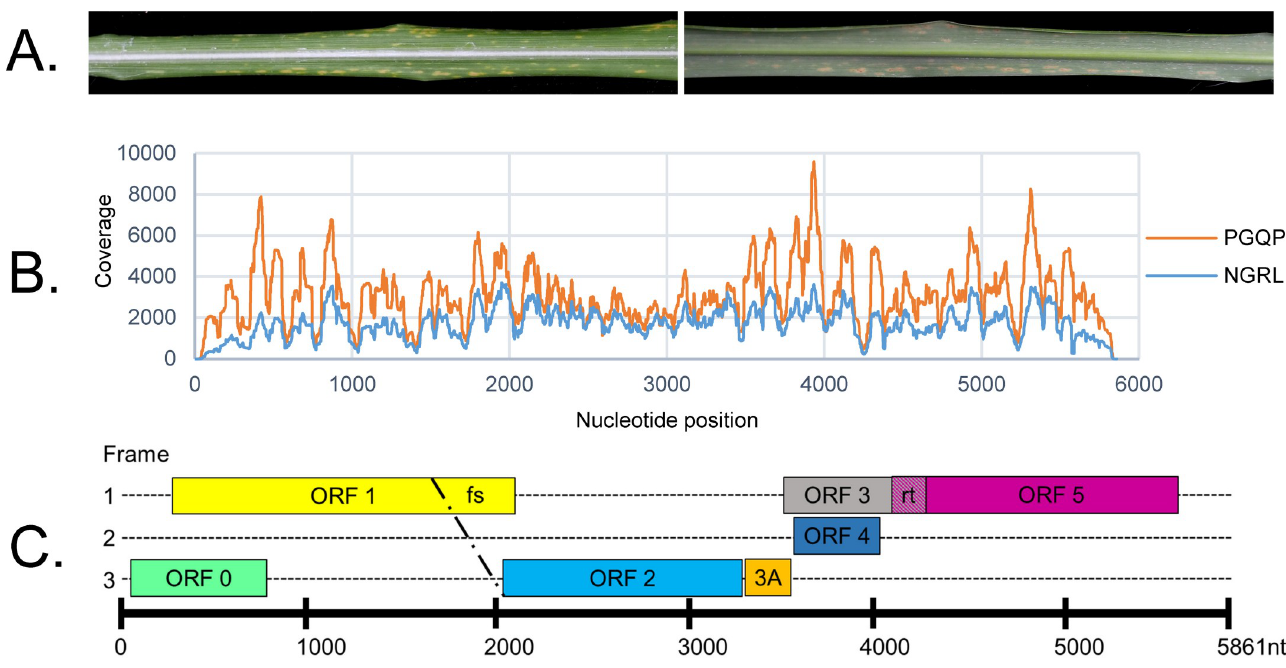
Fig 1. Virus symptoms, sequencing, and genome analysis. (A) Adaxial and abaxial sides of a Miscanthus sinensis leaf displaying viral infection symptoms. (B) Depth of coverage at each nucleotide position obtained by high-throughput sequencing. (C) Schematic representation of Miscanthus yellow fleck virus genome organization. Open Reading Frames (ORFs) were identified using ORF Finder (National Center for Biotechnology Information). The nucleotide positions of the ORFs depicted here are as follows in brackets: ORF0 [57–854], ORF1 [250–2100], ORF1-2 [250–3356], ORF3A [3414–3569], ORF3 [3553–4140], ORF4 [3584– 4036], and ORF3-5 [3553–5589]. The 5’ untranslated region (UTR), internal UTR, and 3’ UTR are predicted to correspond to nucleotide positions 1–56, 3357– 3413, and 5590–5861, respectively. fs denotes the predicted -1 frame shift at nucleotide position 1650, and rt denotes the predicted readthrough stop codon at nucleotide positions 4141–4143. Predicted protein products from ORFs are listed in Table 2. The diagram presented here is approximate and not necessarily drawn to scale.